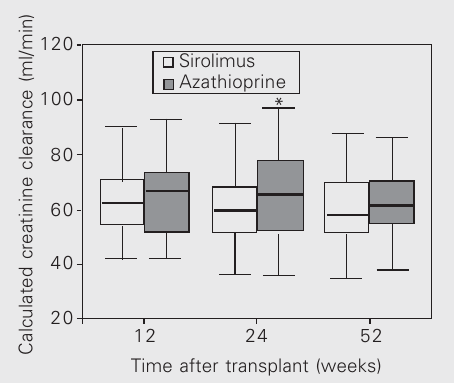
Figure 4. Calculated creatinine clearances by patients receiving sirolimus or azathioprine. The middle horizontal thick bar is the median; the top and bottom square lines indicates the 75th and 25th percentiles; the error bars denote the limits of the 90th and 10th percentiles. *P < 0.05 comparing sirolimus and azathioprine at each time (un- paired Student t